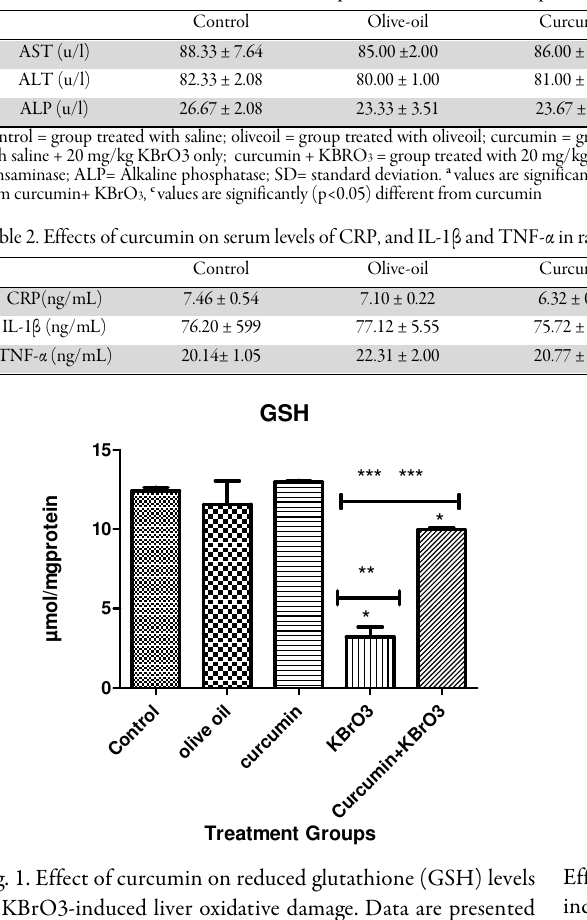
Table 1. Effects of curcumin on some serum hepatic biomarkers in rats exposed to KBrO 3